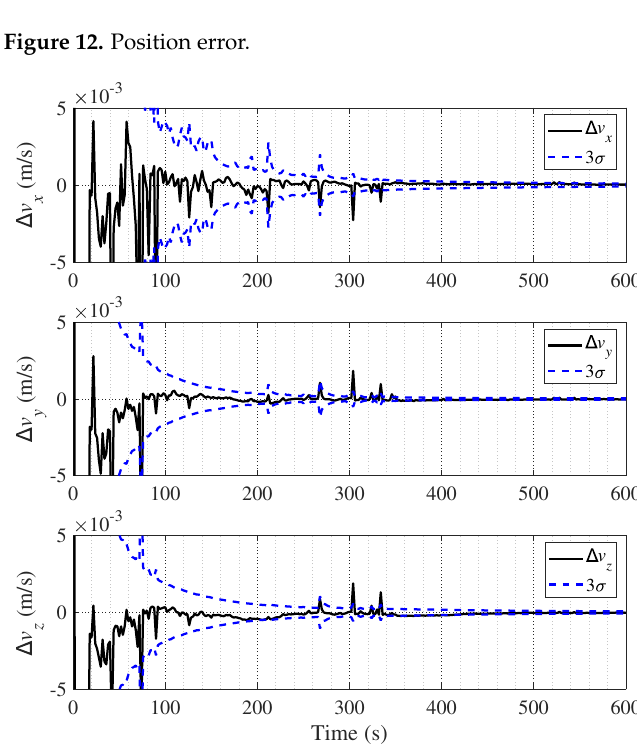
Figure 13. Velocity